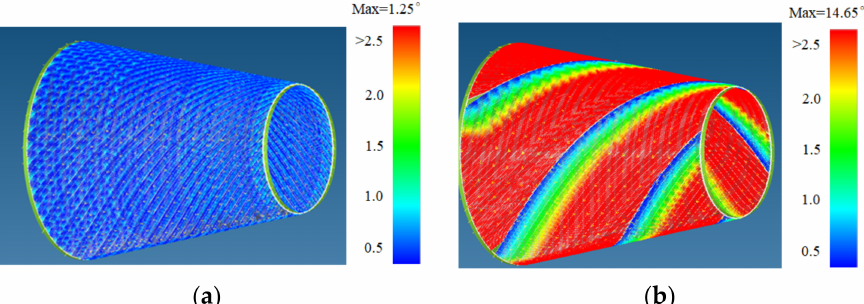
Figure 14. A 45-degree path angle deviation and gaps/overlaps distribution of different path design schemes. ( a ) Circumferential averaging paths. ( b ) Equidistant offset paths based on partition.